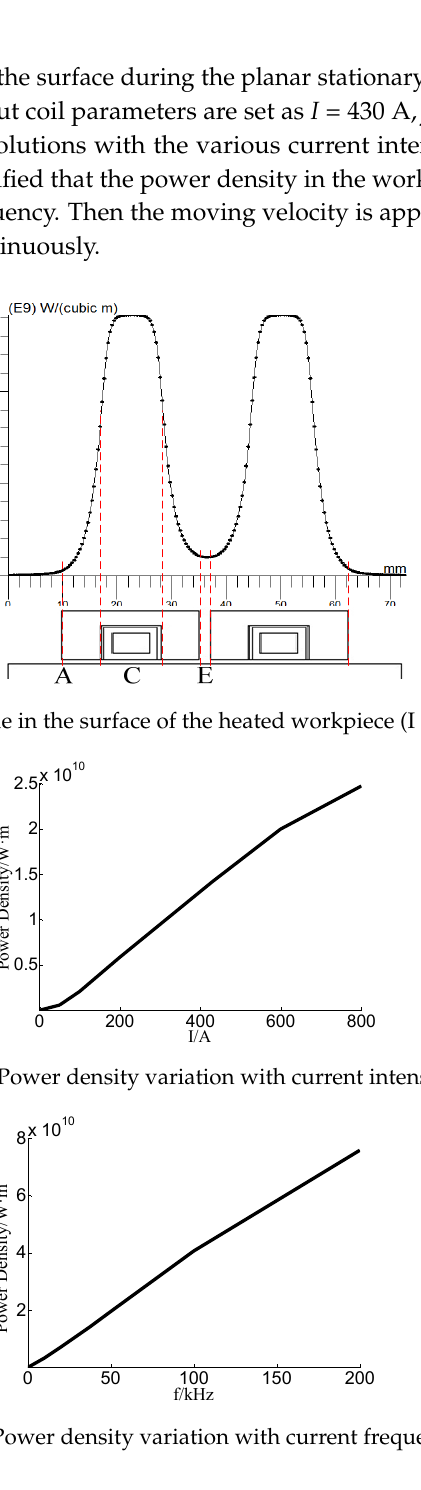
Table 1. Experimental parameters of the planar moving induction heating.